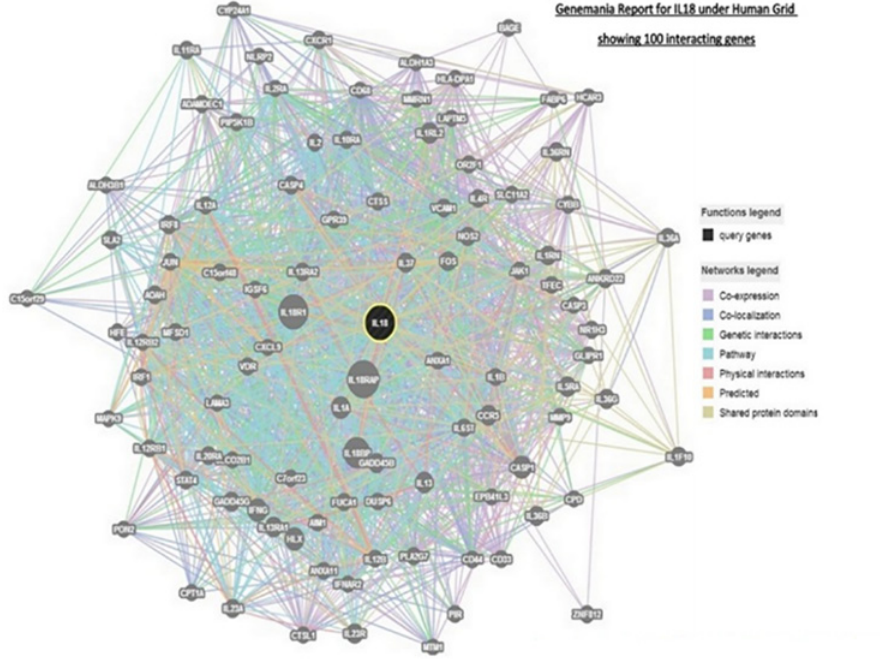
Fig 4. Analysis of protein-protein interaction of